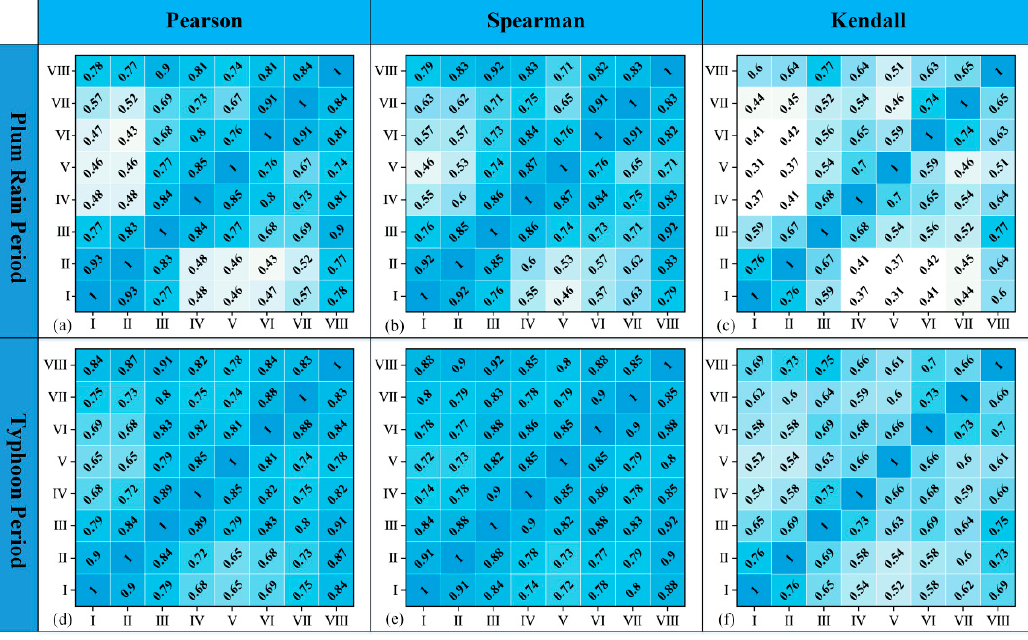
Figure 5. Correlation results of precipitation between four precipitation sub-regions. (a), (b) and (c) are the results for the plum rain period; (d), (e), and (f) are the results for the typhoon period; (a) and